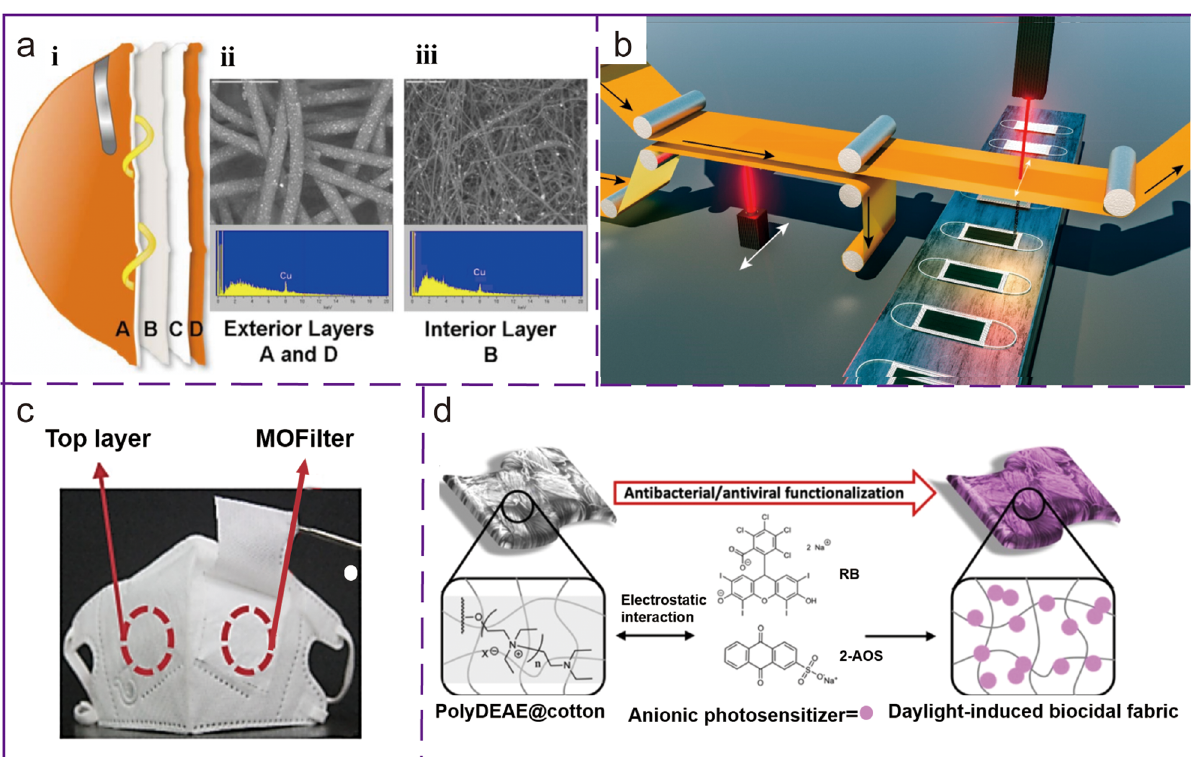
Figure 10: Design of antiviral mask. ( a ) Copper oxide impregnated test mask composition [ 33 ] . ( b ) Illustration of the compatibility of the dual - mode LIFT for roll - to - roll production of a grapheme - coated mask. The direction of rolling movement is a black arrow, and the direction of the laser movement is a white arrow [ 105 ] . ( c ) Antiviral mask made by adding MOFilter layer to two layers of nonwoven fabric [ 9 ] . ( d ) Schematic illustration of the fabrication of daylight - induced antibacterial and antiviral textiles [ 120 ]